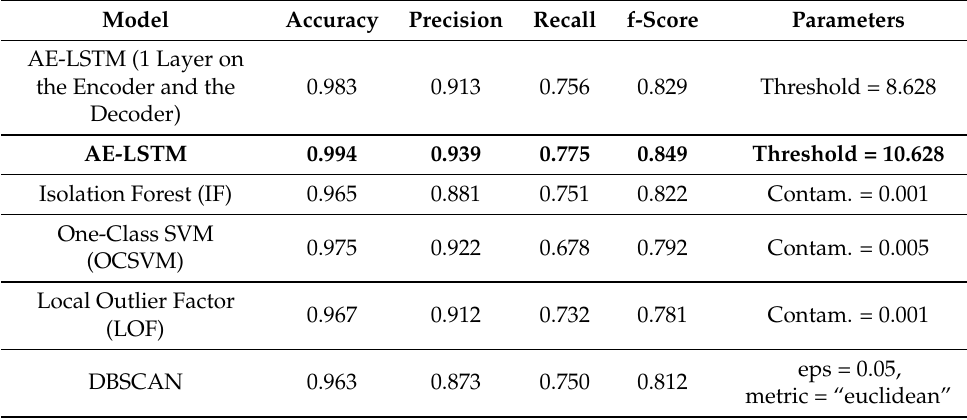
Figure 16. Examples of normal-simulated/anomalous data. Table 10. Comparison of the proposed model with state-of-the-art